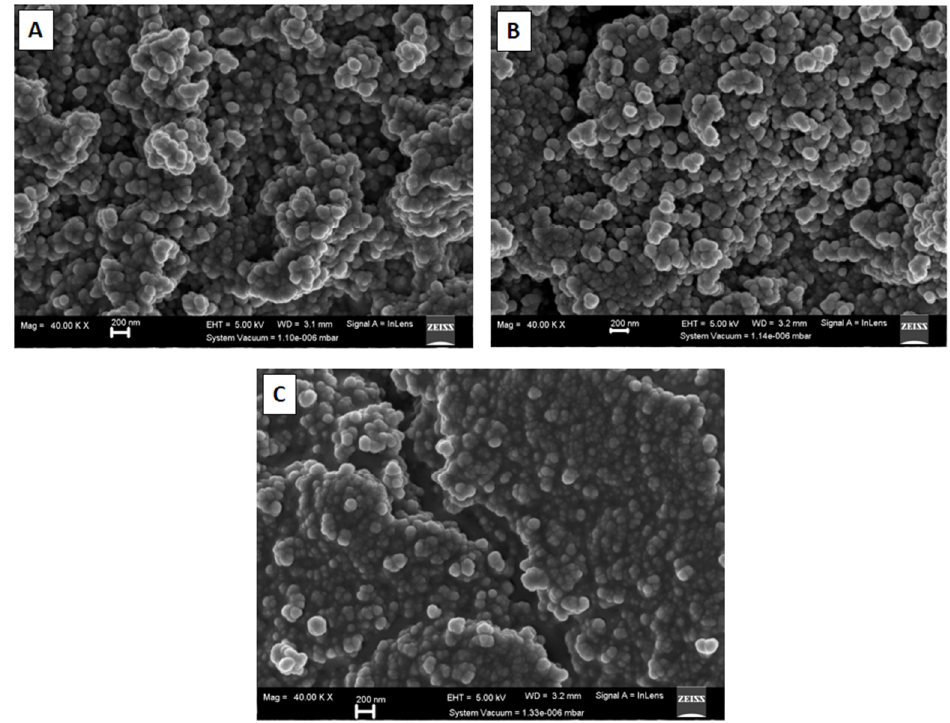
Figure 3. FESEM images of carbon nano-onion supports ( A ), Pd/CNO electro-catalysts ( B ), and Pd-Sn/CNOs electro-catalysts ( C ).